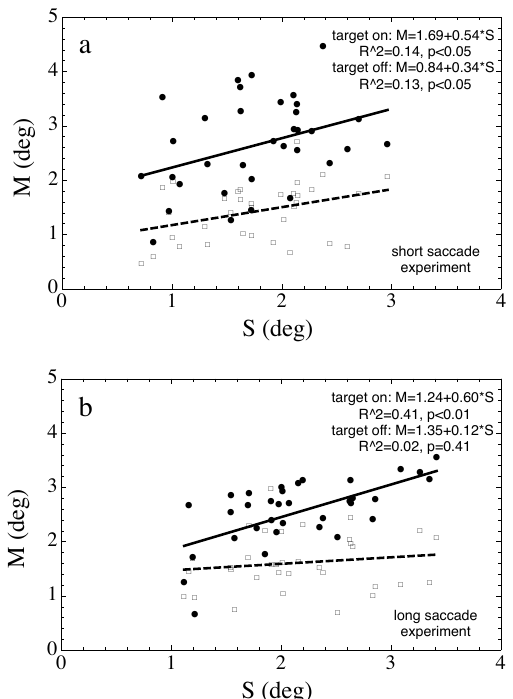
Figure 10 . Correlations. Correlation between mislocalization M at each position in the testing field and the corresponding amount of adaptive shift S at that position in the short sac- cade experiment (a) and in the long saccade experiment (b). Filled circles indicate target on localization trials and open squares target off localization